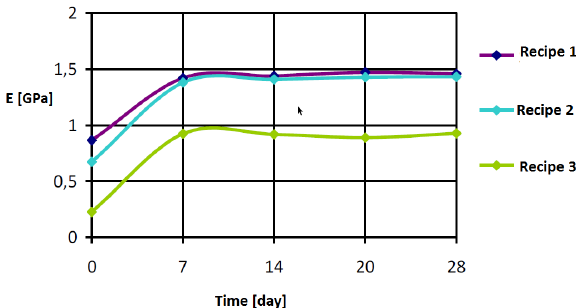
Figure 7. Volume changes over time – recycled plaster boards